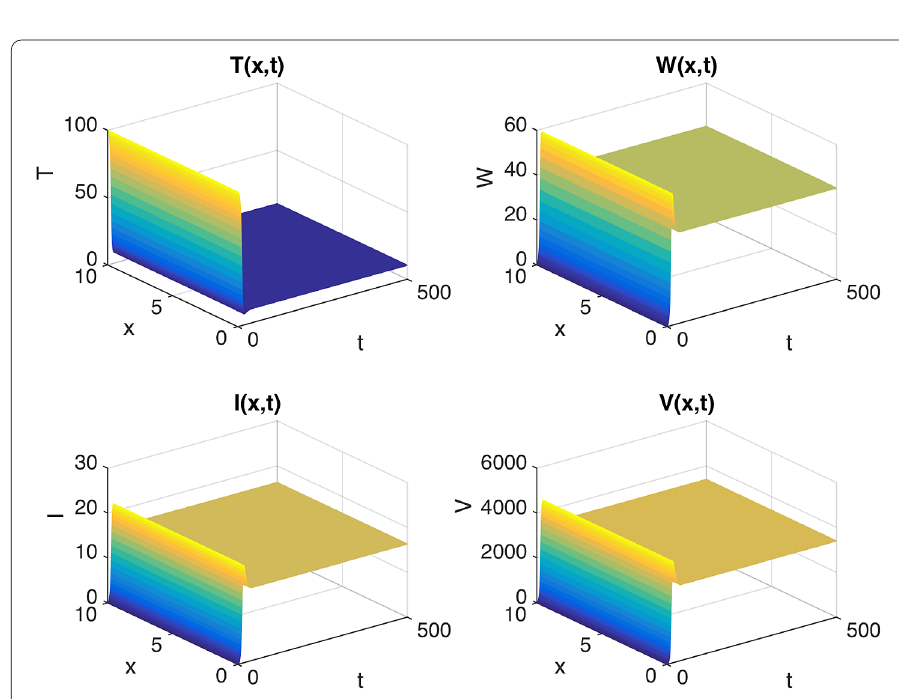
Figure 2 R 0 = 9.5879 > 1. The infection equilibrium E ∗ is globally asymptotically